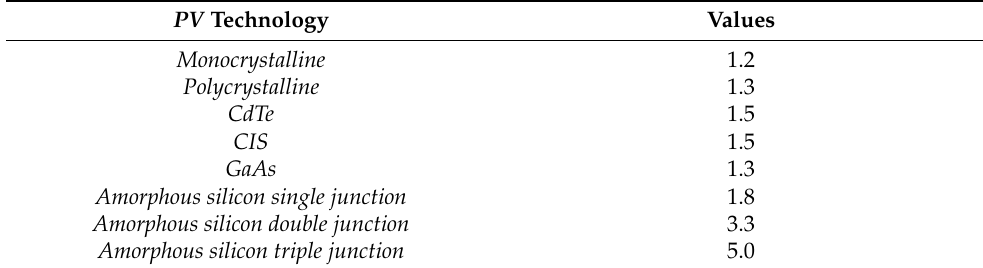
Table 1. The ideal factor depends on the PV technology